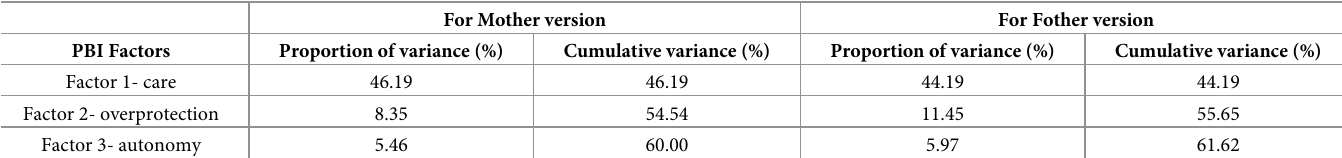
Table 4. Total explained variance for identified factors of Polish version of PBI (in group of adolescents, n =